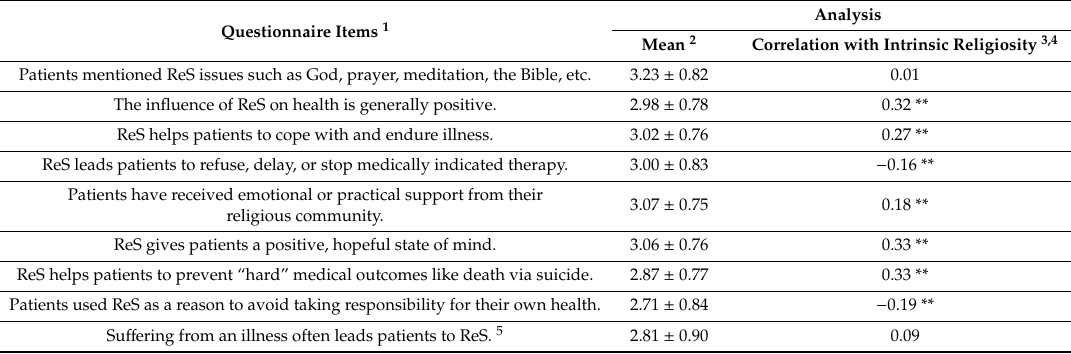
Table 4. Experiences with religious and spiritual aspects of patients from